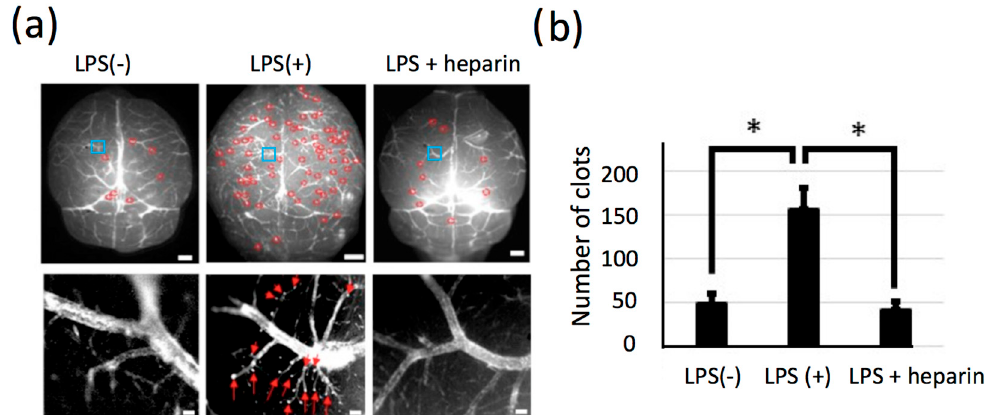
Figure 7. ( a ) Upper panel: NIR fluorescence images (>1000 nm) of cerebral blood vessels of isolated mouse brains. Left: LPS( − ), Middle: LPS(+), Right: LPS + heparin. Red circles: clots. Blue squares: region of interests for the magnified views of lower panels. Scale bars: 1 mm. Lower panel: magnified NIR fluorescence image of cerebral blood vessels at the bregma. Red arrows: clots. Scale bars: 100 µ m; ( b ) Number of clots for each mouse. *: p < 0.05, number of mice: LPS( − ): n = 5, LPS(+): n = 5, LPS + heparin: n = 4.